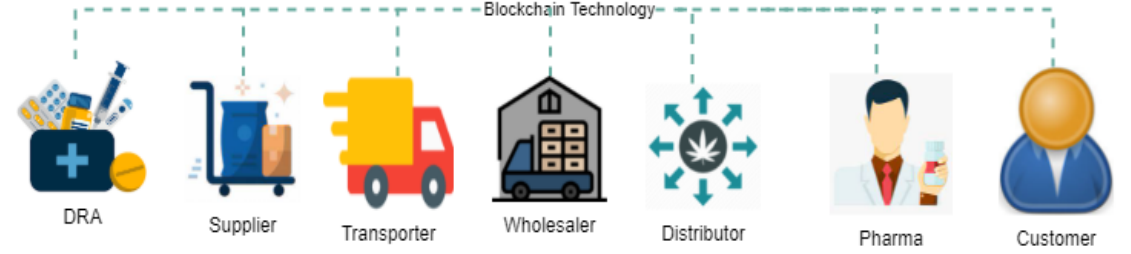
Figure 4. Traceability using blockchain.